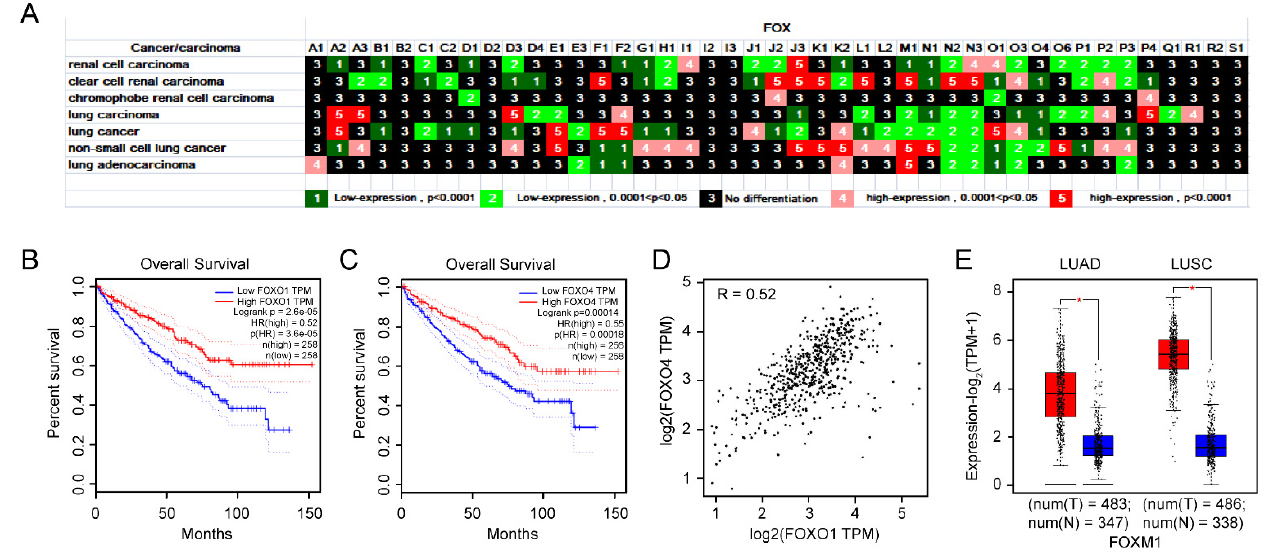
Figure 6. Differential expression of FOX genes in renal cell carcinoma and lung cancer ( A ). ( B , C ) Effects of the respective expression level of FOXO1 and FOXO4 on the survival rate of KIRC patients. ( D ) Pearson correlation coefficient analysis of FOXO1 and FOXO4 in KIRC tumor and normal tissues. ( E ) The differential expression of FOXM1 in LUAD, LUSC, and normal tissues. p values less than 0.05 were considered to be statistically significant, * p <